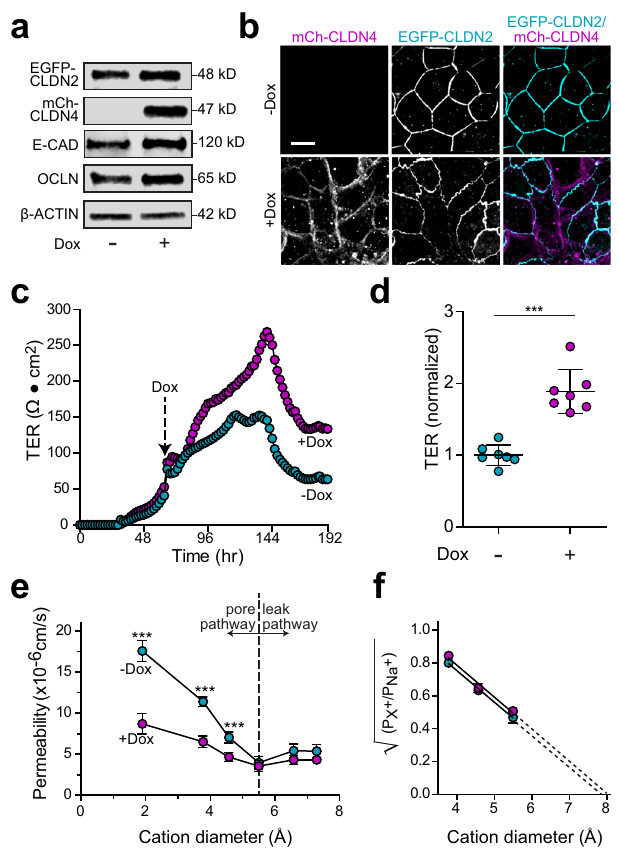
Fig. 2 Claudin-4 markedly reduces paracellular small cation conductance in claudin-2 expressing monolayers. a Immunoblots of claudin-4 knockout (C4KO) cells expressing EGFP-claudin-2 (EGFP-CLDN2) without ( − Dox) or with ( + Dox) mCherry-claudin-4 (mCh-CLDN4) expression. Data are representative of 5 independent